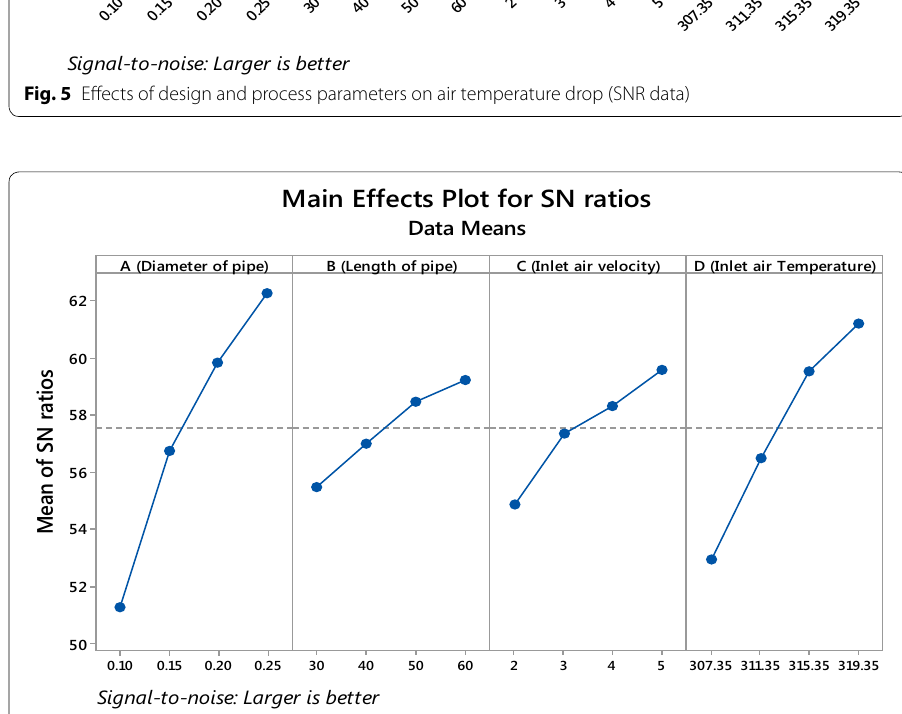
Fig. 6 Effects of design and process parameters on total heat transfer rate (SNR